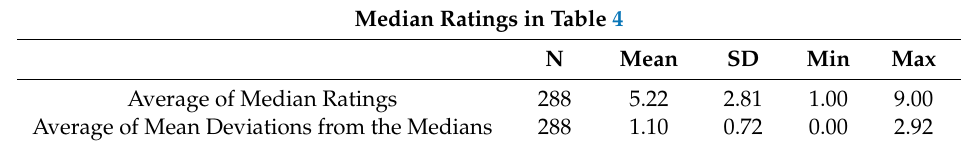
Table 4. Average panel median and average mean absolute deviation from median.